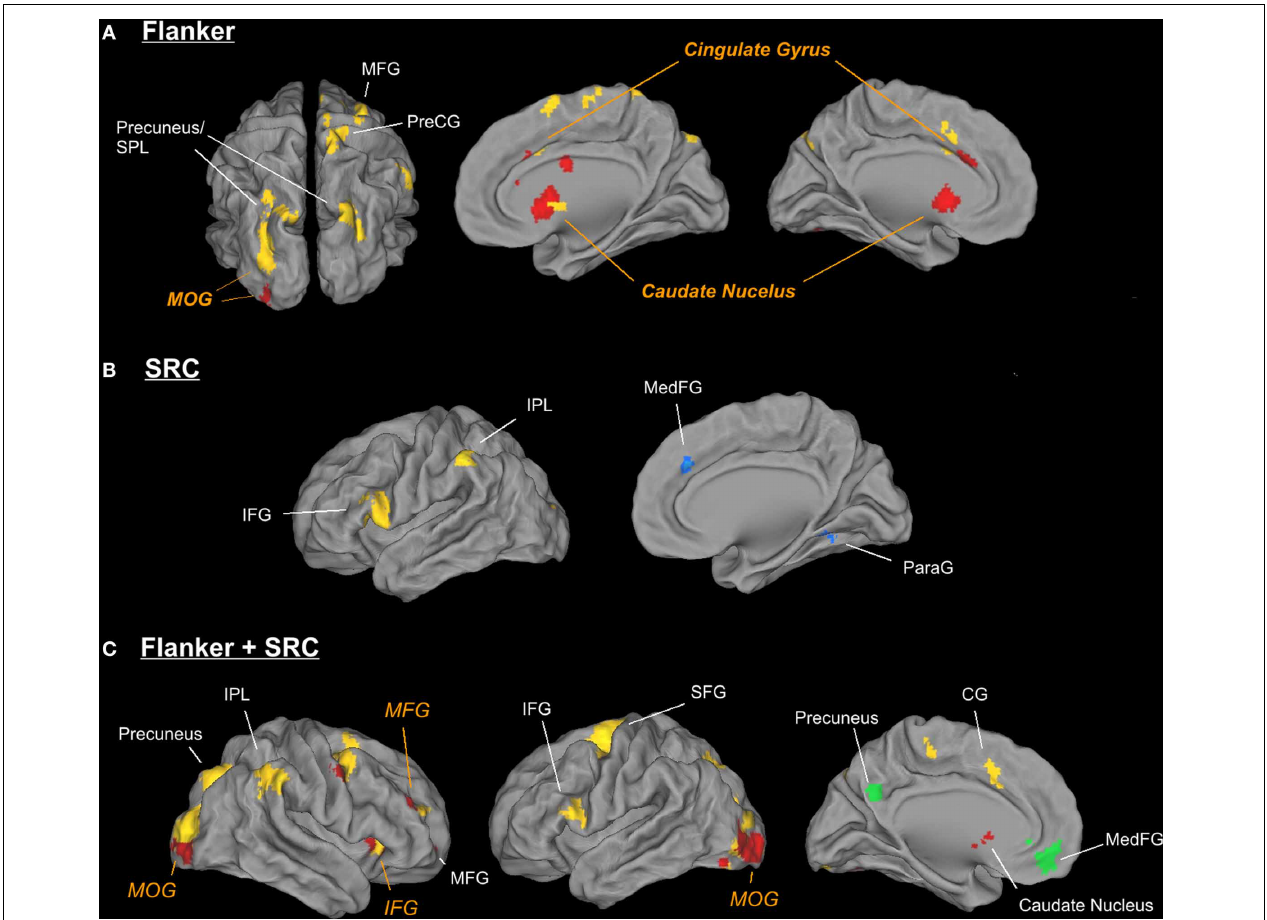
FIGURE 3 | Illustration of different activation patterns for the Flanker (A), the SRC (B), and the double conflict (C) conditions in young and elderly participants. Activation sites of elderly participants are displayed in yellow